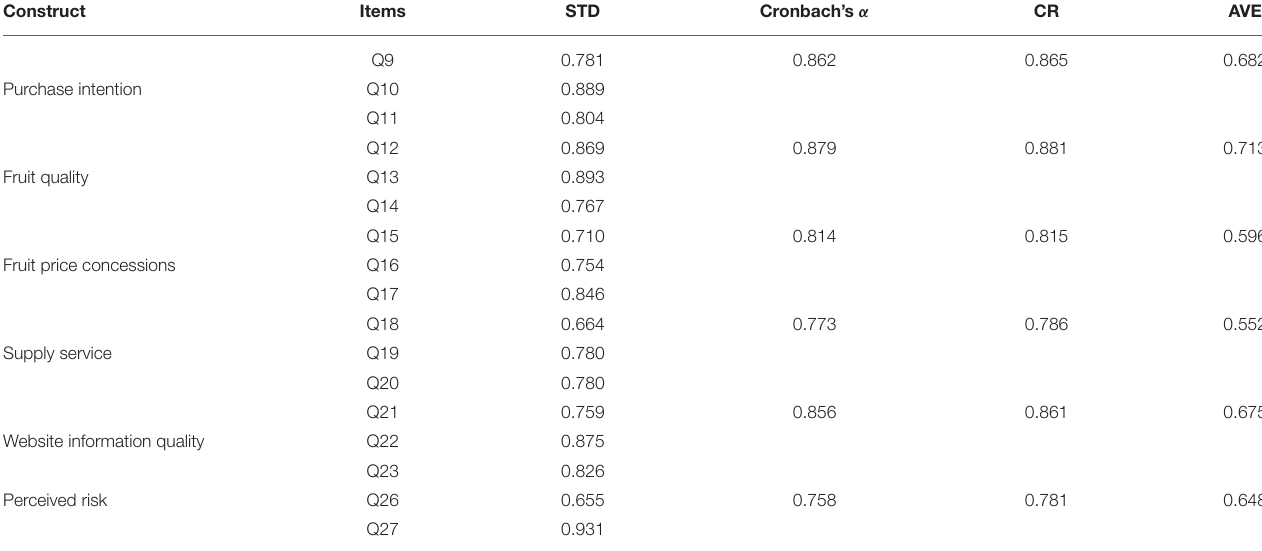
TABLE 2 | Measurement items and reliability results.